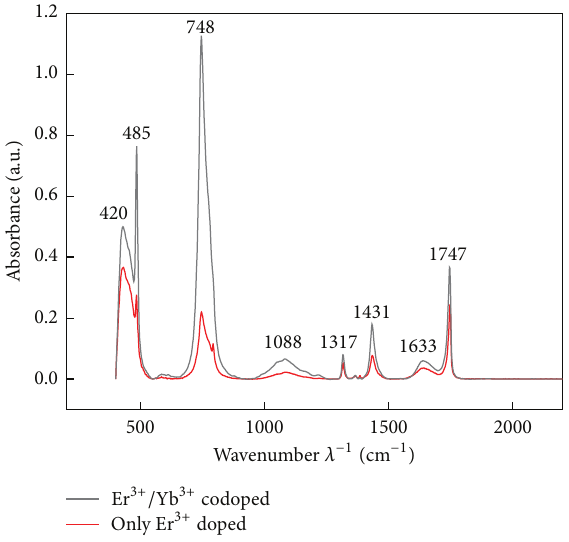
Figure 5: FT-IR spectra of Er 3+ and Er 3+ /Yb 3+ doped nanocrystals.